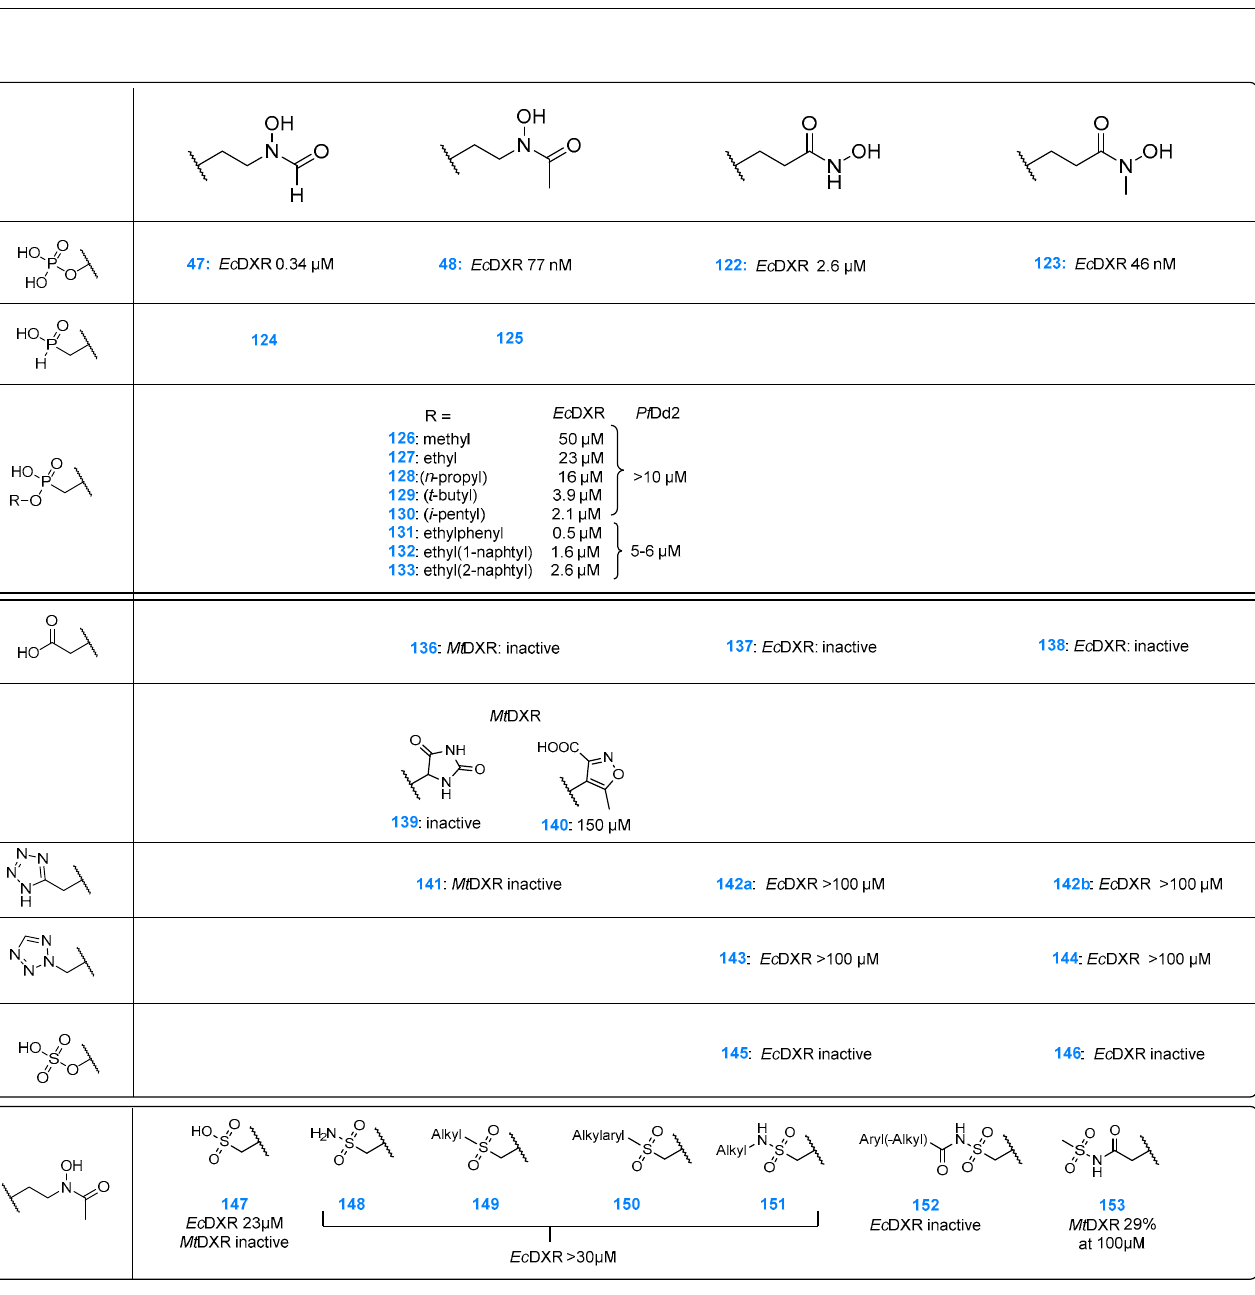
Figure 28. Biological data of phosphonic acid isosteres. Light blue: hydroxamate moiety. Grey: hydroxamic acid moiety. a: R = H. b: R = methyl. n.d. = not determined. Fosmidomycin ( 1 ) as a reference compound.